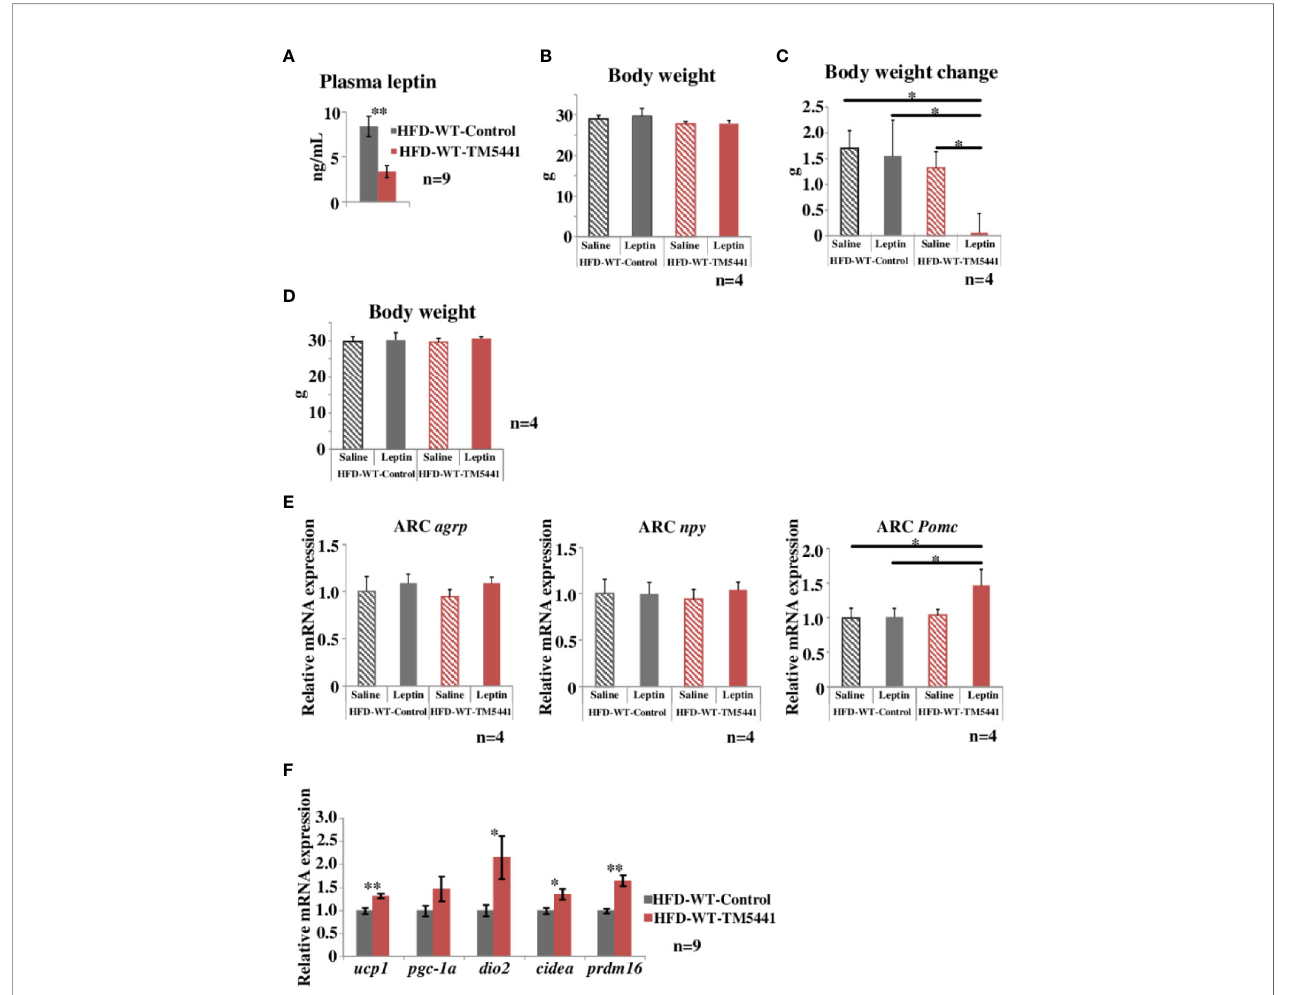
FIGURE 4 | Evaluation of leptin sensitivity in lard-rich HFD fed mice treated with TM5441. (A) Plasma leptin levels of HFD-WT-TM5441 mice and HFD-WT-Control mice. Results are expressed as mean ± SE of n = 9 mice. (B) Body weight of HFD-WT-TM5441-Leptin mice, HFD-WT-Control-Leptin mice, HFD-WT-TM5441-Saline mice, and HFD-WT-Control-Saline mice. Ten-week-old WT mice that had been pre-fed the lard-rich HFD for 2 weeks were given either lard-rich HFD mixed with TM5441 or lard-rich HFD for 1 week. Results are expressed as mean ± SE of n = 4 mice. (C) Body weight changes during leptin treatment. Mice were given a daily intraperitoneal injection of either leptin (HFD-WT-TM5441-Leptin mice or HFD-WT-Control-Leptin mice) or saline (HFD-WT-TM5441-Saline mice or HFD-WT-Control- Saline mice) for 5 consecutive days. Body weight immediately before the fi rst leptin injection was subtracted from body weight 24 h after the last injection. Results are expressed as mean ± SE of n = 4 mice. (D) Body weight of HFD-WT-TM5441-Leptin mice, HFD-WT-Control-Leptin mice, HFD-WT-TM5441-Saline mice, and HFD- WT-Control-Saline mice. Ten-week-old WT mice that had been pre-fed the lard-rich HFD for 2 weeks were given either lard-rich HFD mixed with TM5441 or lard-rich HFD for 1 week. Results are expressed as mean ± SE of n = 4 mice. (E) Relative mRNA expressions of agouti-related peptide ( agrp ), neuropeptide y ( npy ), and proopiomelanocortin ( Pomc ) in the hypothalamic arcuate nucleus (ARC). Mice were fasted for 24 h and then given a single intraperitoneal injection of either leptin (HFD- WT-TM5441-Leptin mice or HFD-WT-Control-Leptin mice) or saline (HFD-WT-TM5441-Saline mice or HFD-WT-Control-Saline mice). Brain samples were harvested 4 h after the injection. Results are expressed as mean ± SE of n = 4 mice. (F) Relative mRNA expressions of uncoupling protein 1 ( ucp1 ), peroxisome proliferative activated receptor gamma coactivator 1 alpha ( pgc-1a ), type II iodothyronine deiodinase ( dio2 ), cell death-inducing DNA fragmentation factor alpha subunit-like effector A ( cidea ), and PR domain containing 16 ( prdm16 ) in brown adipose tissue (BAT). Ten-week-old WT mice that had been pre-fed the lard-rich HFD for 2 weeks were given either lard-rich HFD mixed with TM5441 or lard-rich HFD for 1 week. Results are expressed as mean ± SE of n = 9 mice. * P < 0.05 and ** P <